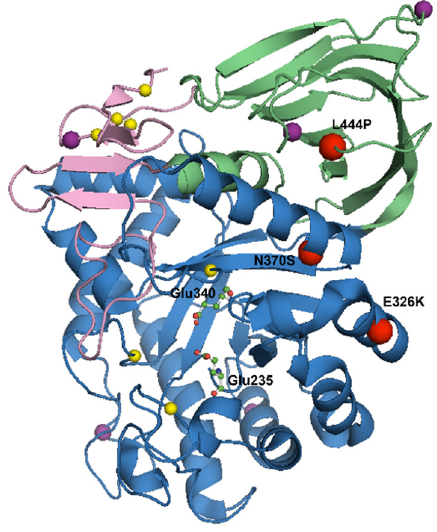
Figure 1. Crystal structure of glucocerebrosidase at pH 5.5 (PDB code 3GXI). Domain I is shown in pink. Domain II is shown in green. Domain III is shown in blue. The active site catalytic residues Glu 235 and Glu 340 are shown as ball-and-stick models. The five N -linked glycosylation sites (Asn 19, Asn 59, Asn 146, Asn 270 and Asn 462) are shown as purple spheres. The free cysteine residues are shown as yellow spheres. The three most common GBA mutations, L444P, N370S and E326K, are labelled as red spheres. Figure created using The PyMOL Molecular Graphics System, Version 1.2r3pre, Schrödinger, LLC .